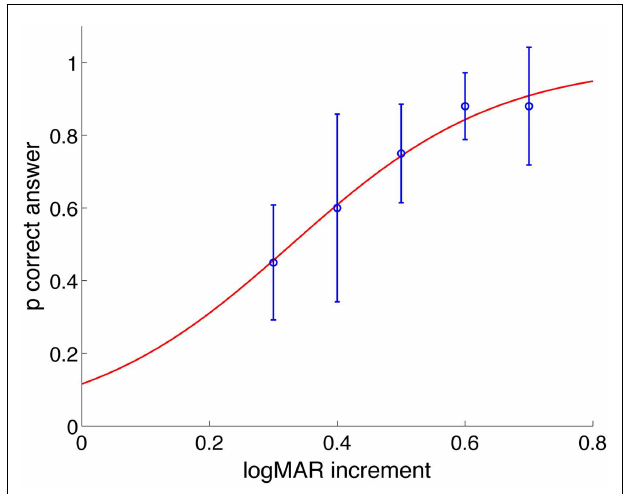
FIGURE 1 | Probability of correct answers as a function of logMAR increment of all subjects .Values are fitted with a psychometric logistic function. For increment of 0.5 logMAR and less, the probability of providing a correct answer decreases statistically